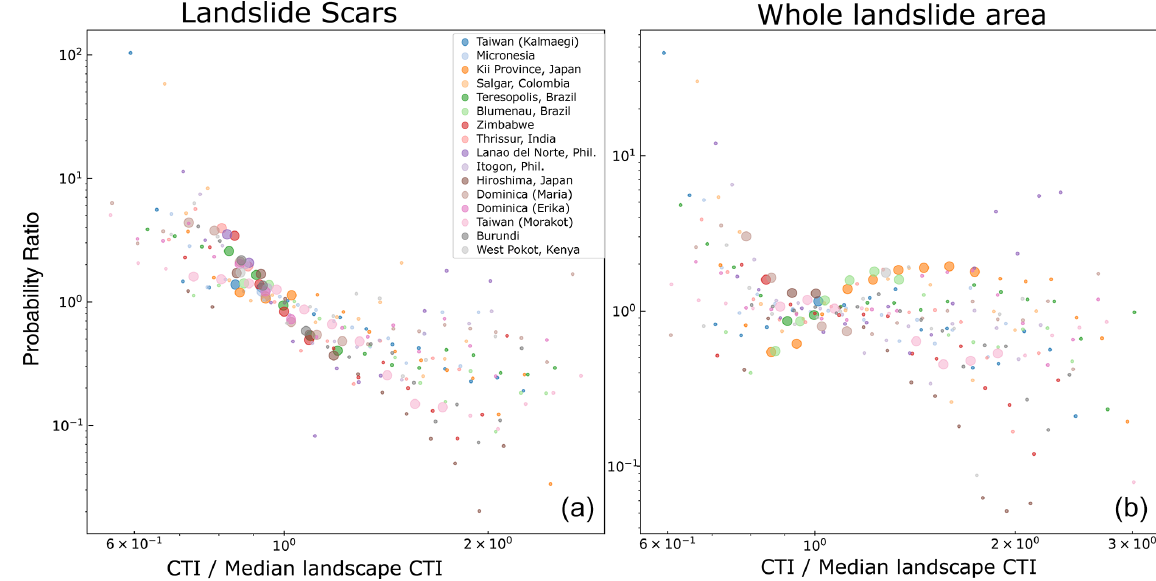
Figure 6. Same as Fig. 4 but for the compound topographic index (CTI). Note that the x axis is a logarithmic scale.